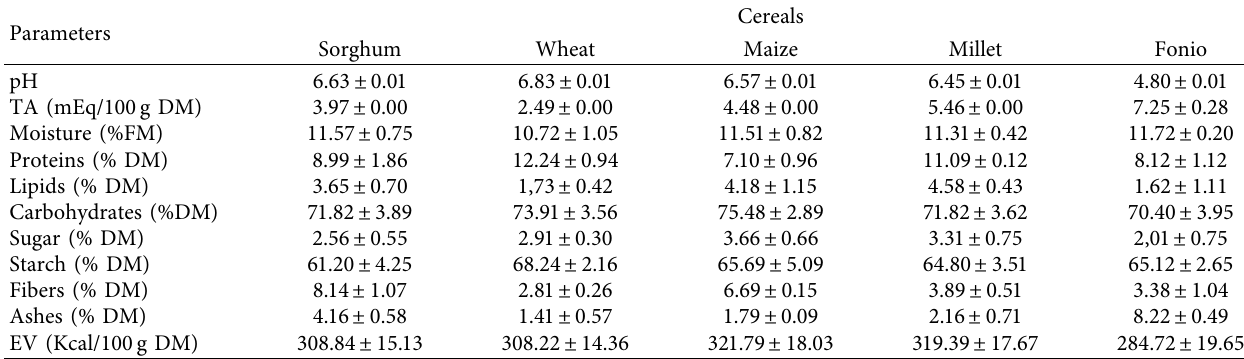
Table 4: Physicochemical composition of Sorghum and other